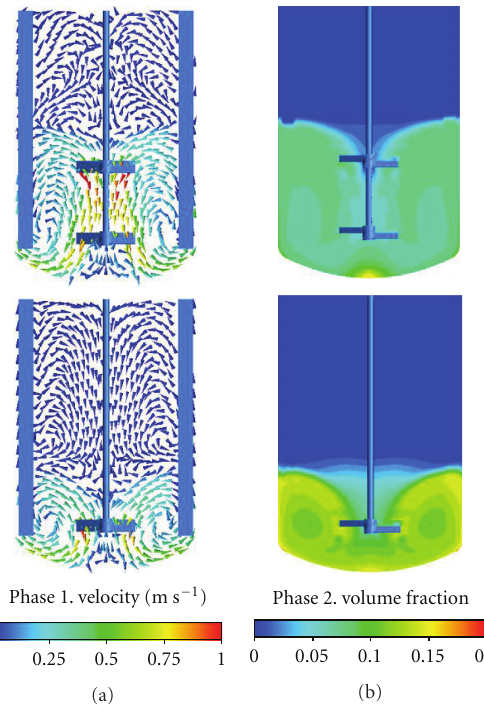
Figure 4: Contour plots for 200RPM, 10% (w/w) loading for single- and dual-impeller configurations on a midplane. (a) Velocity vector of liquid phase. (b) Volume fraction of solid phase.